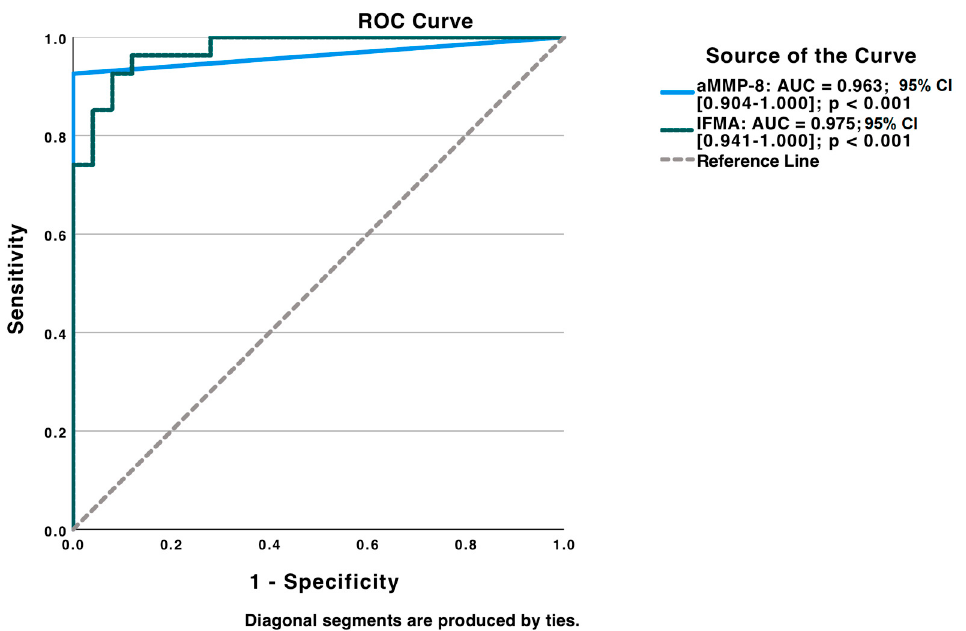
Figure 6. Receiver operating characteristic (ROC) analysis tested for screening diagnostic ability of aMMP-8 PoC and IFMA tests to discriminate between periodontitis and periodontal health. AUC was also calculated and showed excellent discrimination ability between peri- odontitis and periodontally healthy groups (aMMP-8 POC test = 0.963; 95% CI: 0.904–1.000; p < 0.001 and aMMP-8 IFMA test = 0.975; 95% CI: 0.941–1.000; p < 0.001). Optimal cut- offs for aMMP-8 POC and IFMA tests were estimated by Youden’s Index (aMMP-8 POC test: 20.0 ng/mL; sensitivity: 0.852; specificity: 1.000; aMMP-8 IFMA test: 43.20 ng/mL; sensitivity: 0.926; specificity: 0.920).